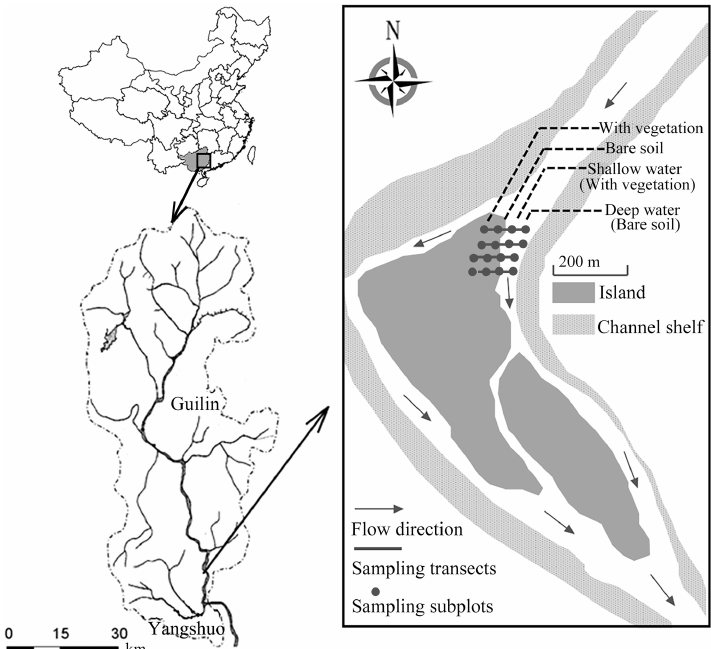
Figure A1. The location of the study site in the island downstream of the Lijiang in Guilin city, Southwest China (25 ◦ 06 (cid:48) N, 110 ◦ 25 (cid:48) E). There were four sampling transects (black lines), each spaced 3m apart, and four subplots (black squares) were arranged in each transect, with a distance of 5–8m between them.